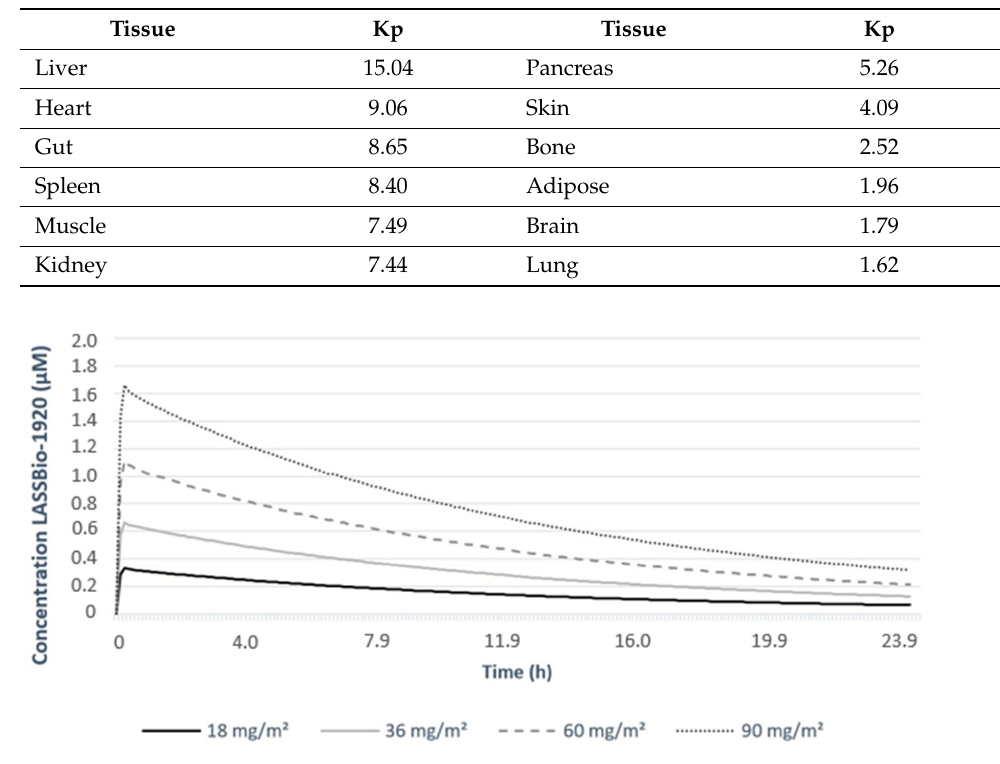
Table 5. LASSBio – 1920 PKPD Profiles in animal simulation module.